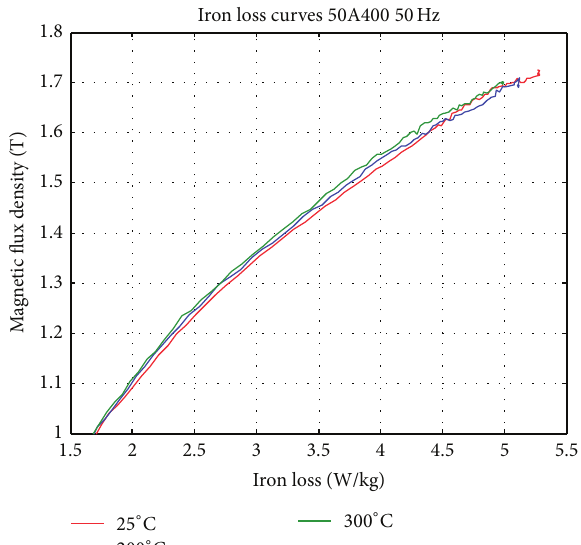
Figure 16: Iron loss partial enlargement measurement results obtained at different temperature. ( 𝐵 = 1.0–1.7